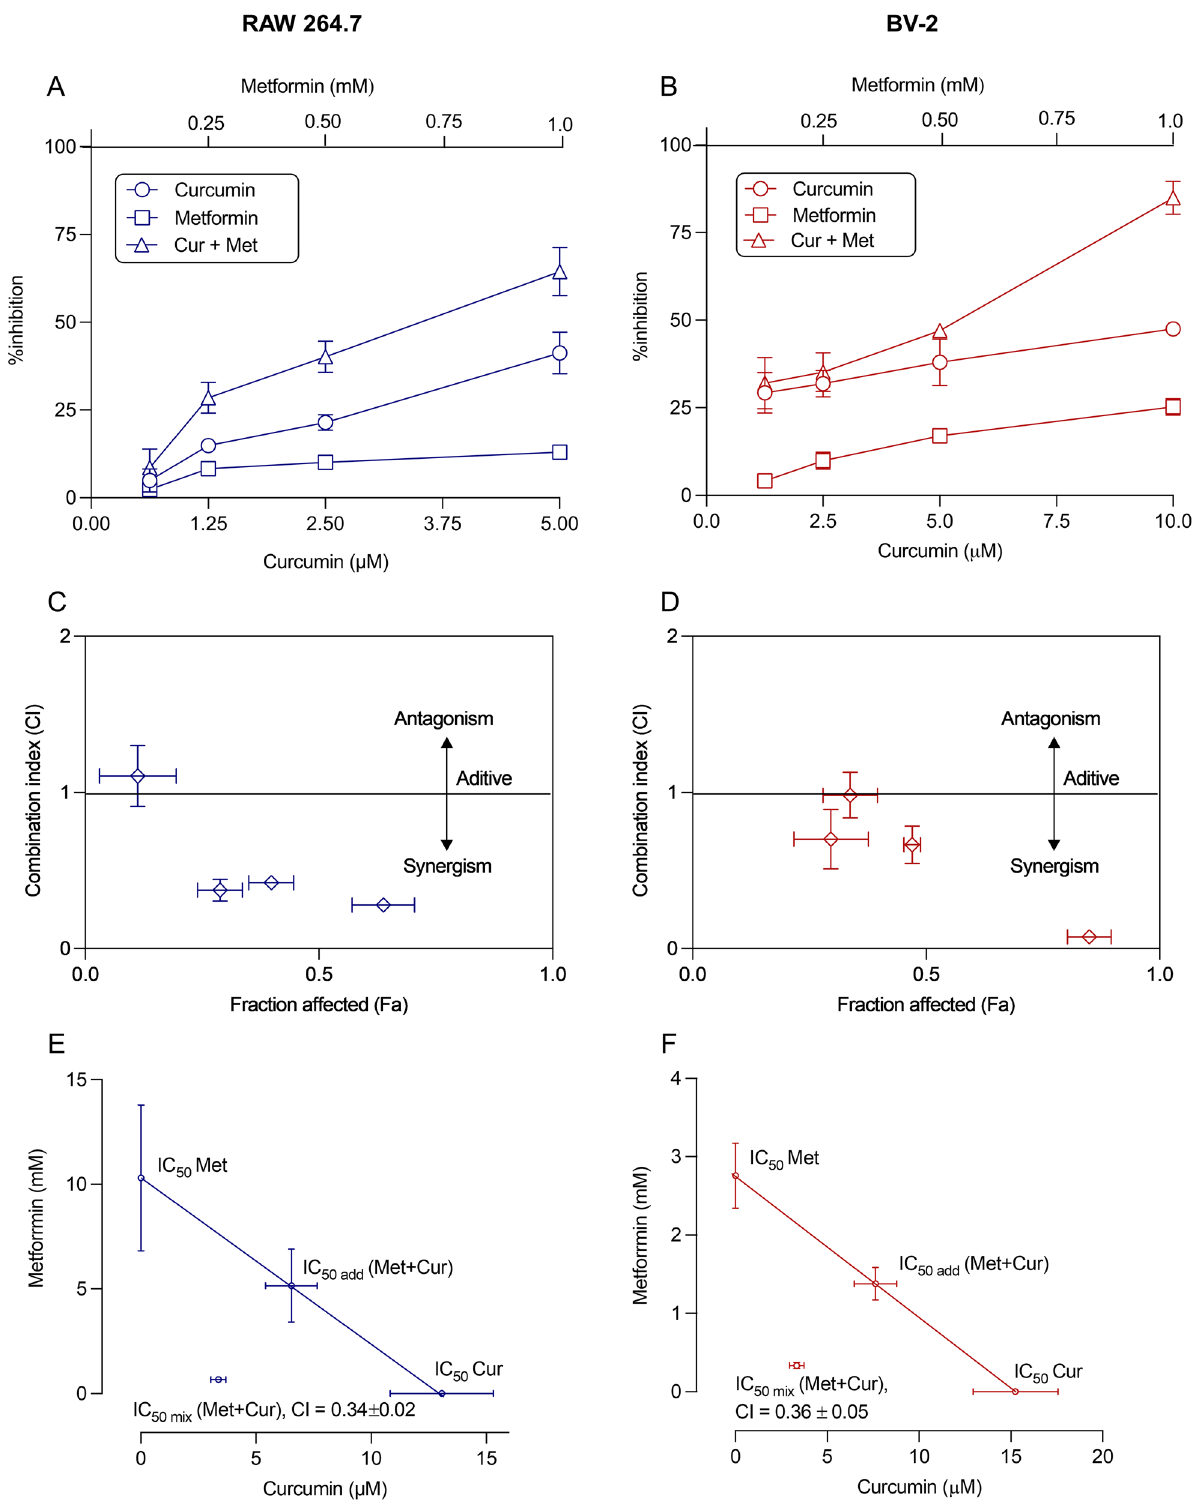
Figure 3. Anti-inflammatory effects of curcumin and metformin alone and in combination on peripheral and central immune cells. ( A,B ) Dose–response curves of NO inhibitory effect of curcumin and metformin alone or in combination on LPS-induced RAW 264.7 macrophage ( A ) and BV-2 microglial ( B ) cells. ( C,D ) Fraction affected (Fa)-combination index (CI) plot for the combined effect of curcumin and metformin on LPS-induced NO production in RAW 264.7 ( C ) and BV-2 ( D ) cells. Generally, CI < 1, CI = 1, and CI > 1 indicate synergistic, additive, and antagonistic interaction, respectively. ( E,F ) Normalized isobologram for the anti-inflammatory effect of curcumin and metformin on RAW 264.7 macrophage ( E ) and BV-2 microglial ( F ) cells. Experimental data are presented as mean ± SD, n = 3 independent